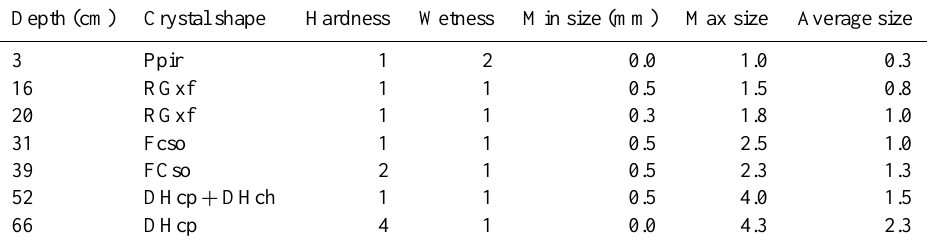
Table 2. The snow structure profile, 3 April 2013, 11:20EET. Snow depth from the snowpack surface (cm), snow grain shape, hand hardness index, and snow wetness index defined according to Fierz et al. (2009). Minimum, maximum, and average snow grain size ((mm), longest axis, 0.25mm resolution) as visually approximated from macro-photographs.